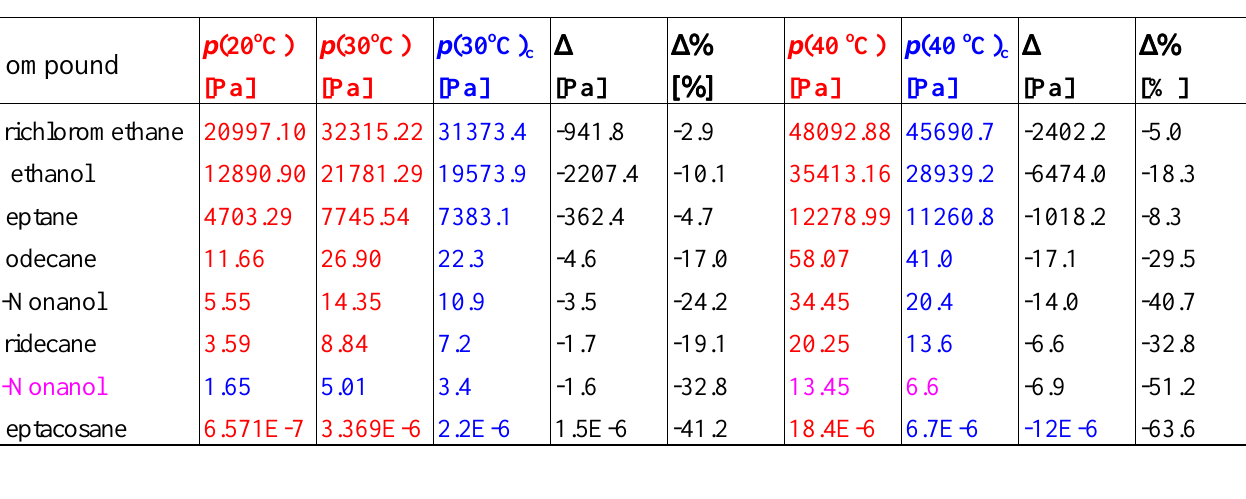
Table 7. Comparison of experimental vapour pressures at 30 and 40 o C with values calculated by equation (3) from the vapour pressure at 20 o